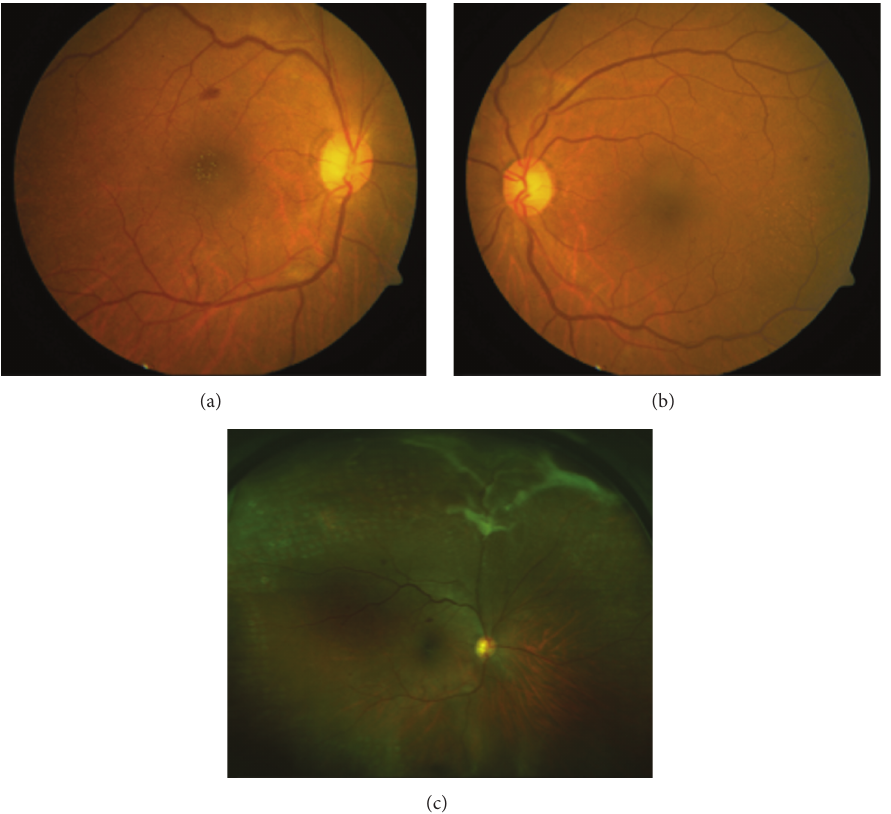
Figure 1: Foveal intraretinal green-yellow crystals were present in the right (a) and left eyes (b) but were asymmetric with relatively more crystals in the right eye. Of note, the right eye also featured regressed sickle cell retinopathy (c) and macular edema, pathologies that were not present in the fellow eye.